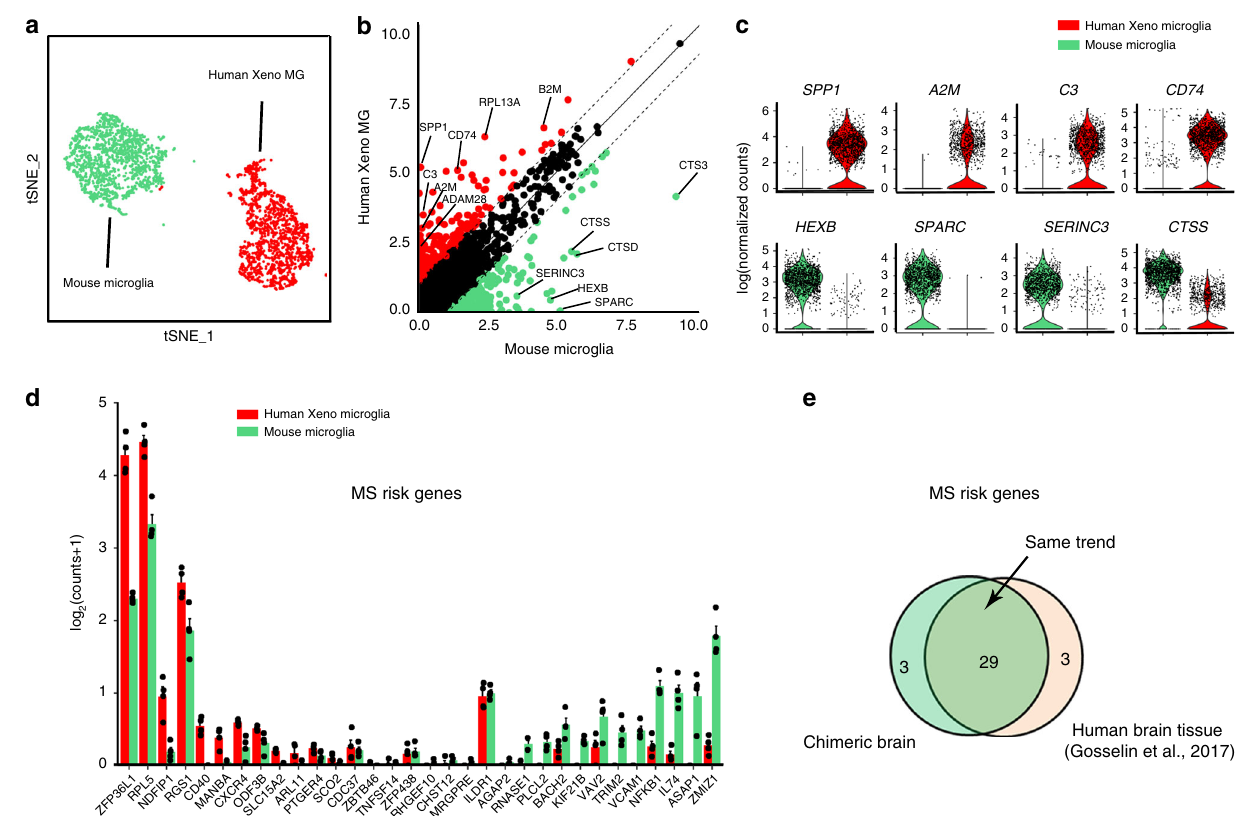
Fig. 5 Transcriptomic pro fi ling analysis of clusters of Xeno MG and mouse microglia. a tSNE plot highlighting only the clusters of human Xeno MG and mouse host microglia. b Scatter plot showing mean mRNA expression levels of human and mouse genes with unique orthologs from Xeno MG and mouse microglia clusters, highlighting the differentially expressed genes (DEGs; at least twofold different) in human Xeno MG (red) or mouse microglia (green) from 6-month-old chimeric mouse brain. Signi fi cantly different DEGs (<5% false discovery rate (FDR) and at least twofold different) are listed in Supplementary Data 2. c Violin plots summarizing expression differences in individual cells within the human Xeno MG and mouse microglia clusters. Dots indicate expression levels (as log normalized counts) of individual cells and the violin shape summarizes the distribution of expression in the population. d Bar plots showing the average expression (mean ± SEM, n = 4 samples) of Multiple sclerosis (MS)-associated genes in Xeno MG and mouse microglia. These genes were reported to be differentially expressed between human and mouse microglia as in Gosselin et al. 7 . Source data are provided as a Source Data fi le. e Venn diagrams showing that majority of the MS associated genes that were reported to be differentially expressed between human and mouse microglia are recapitulated in our chimeric mouse model (29 of